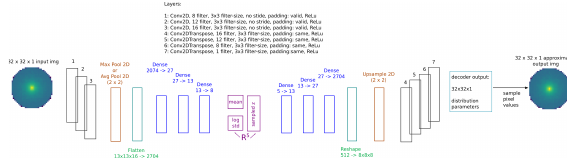
Figure 2. VAE architecure and implementation